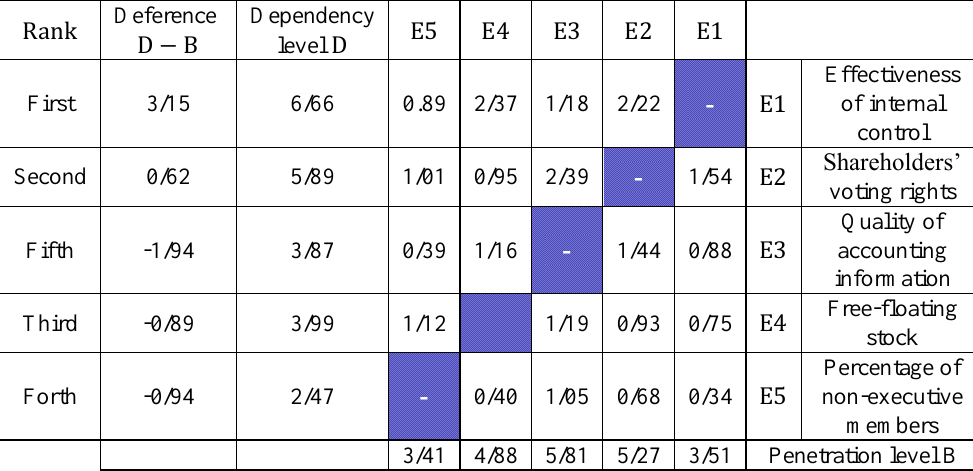
Table 17. Selection of Investor Protection under the existence of the sociocracy